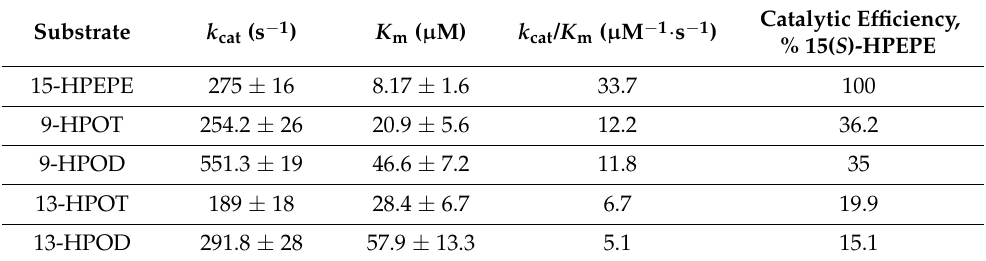
Table 1. Kinetic parameters and substrate specificities of the recombinant CYP74C44.